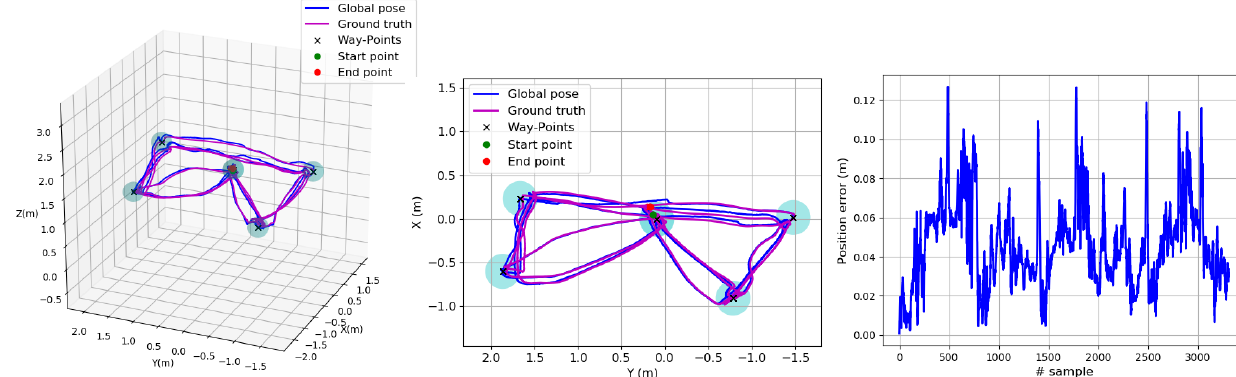
Figure 13. Way-point visitation experiment: ( left ) estimated and true paths, ( middle ) 2D projection of the trajectory, ( right ) position estimation error. In the plots, × in the center of a blue sphere denotes a way-point. (All units are in meters.).